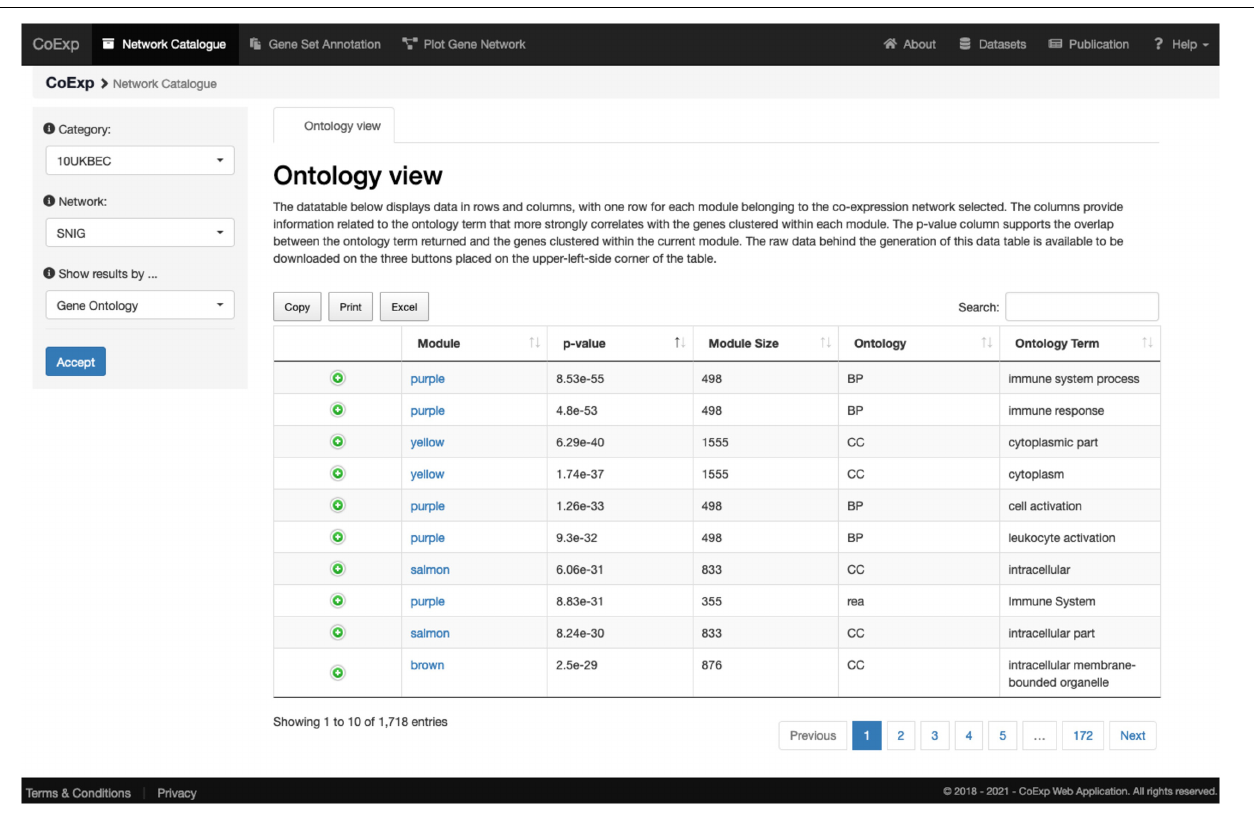
FIGURE 3 | View of the network catalogue when we select the substantia nigra (SNIG) network from the 10UKBEC network family and use the Ontology View. It shows the table corresponding to the functional enrichments obtained using gProfileR. Enriched terms are ordered by p-value by default. In this case, the first two terms provide evidence that the genes in the purple module are enriched for immune-related functions. All annotations can be downloaded in the form of an Excel file for later inspection. Furthermore, if the user is interested in a particular annotation term, he/she can use the search text frame at the top right, to look for terms matching specific keywords. A visual demonstration of all these functionalities is available, as a video, at the Help section of the CoExp web under the “Network Catalogue”